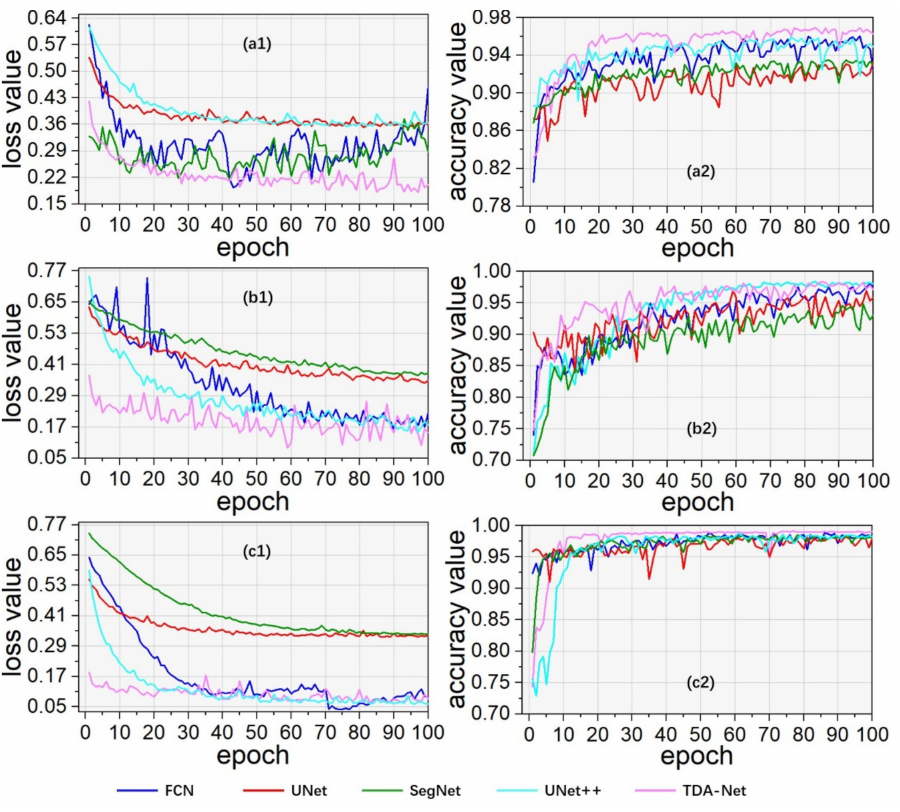
Figure 7. The model curves of ( a1 ) WHU Building dataset loss, ( a2 ) WHU Building dataset accu- racy, ( b1 ) Beirut dataset loss, ( b2 ) Beirut dataset accuracy, ( c1 ) Tianjin dataset loss, and ( c2 ) Tianjin dataset